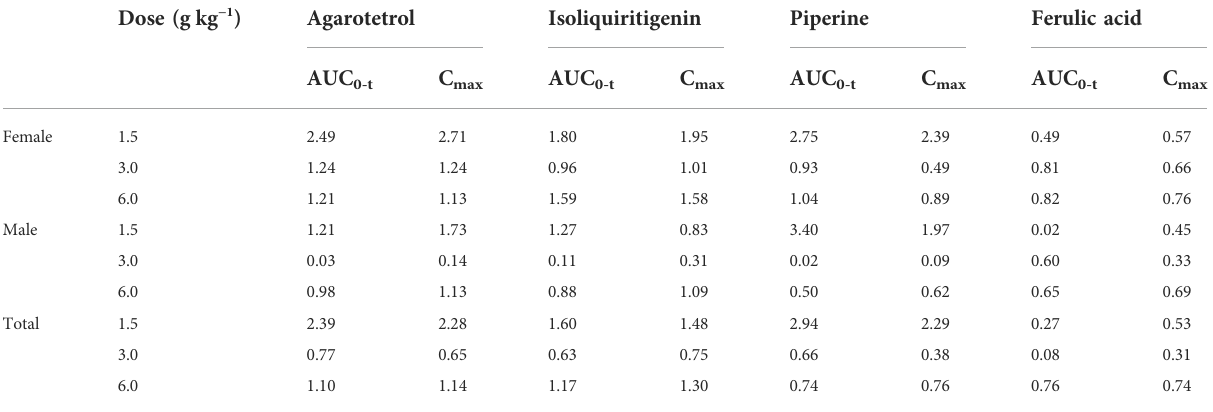
TABLE 14 Accumulation index of systemic exposure of four components in plasma